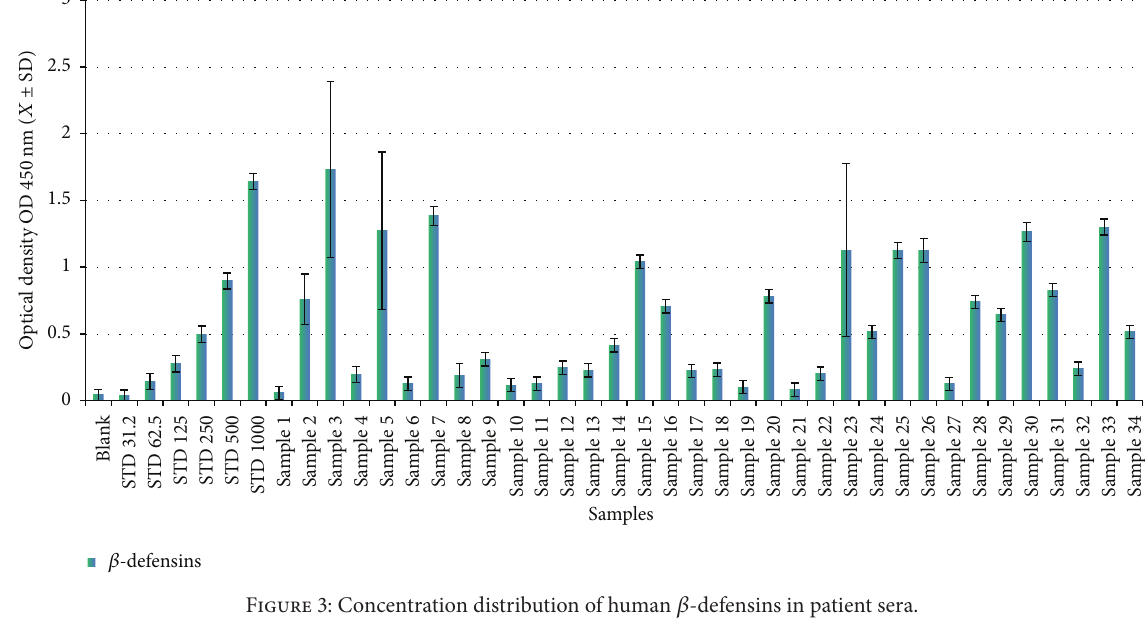
Figure 3: Concentration distribution of human 𝛽 -defensins in patient sera.